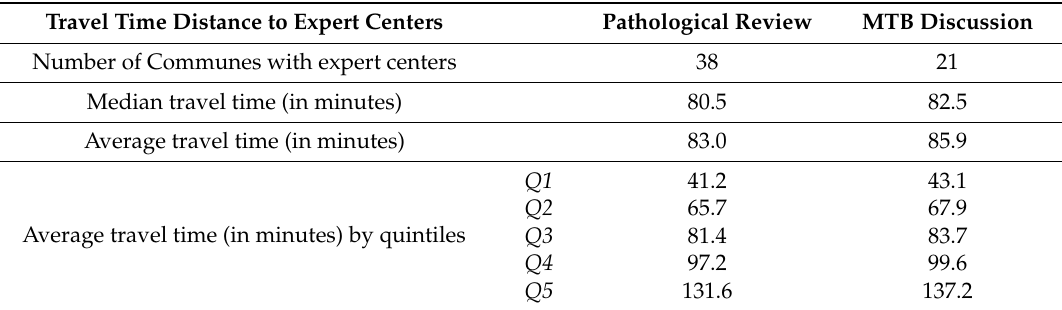
Table 2. Remoteness and geographical inequalities in the access to sarcoma expertise for patients from mainland France.